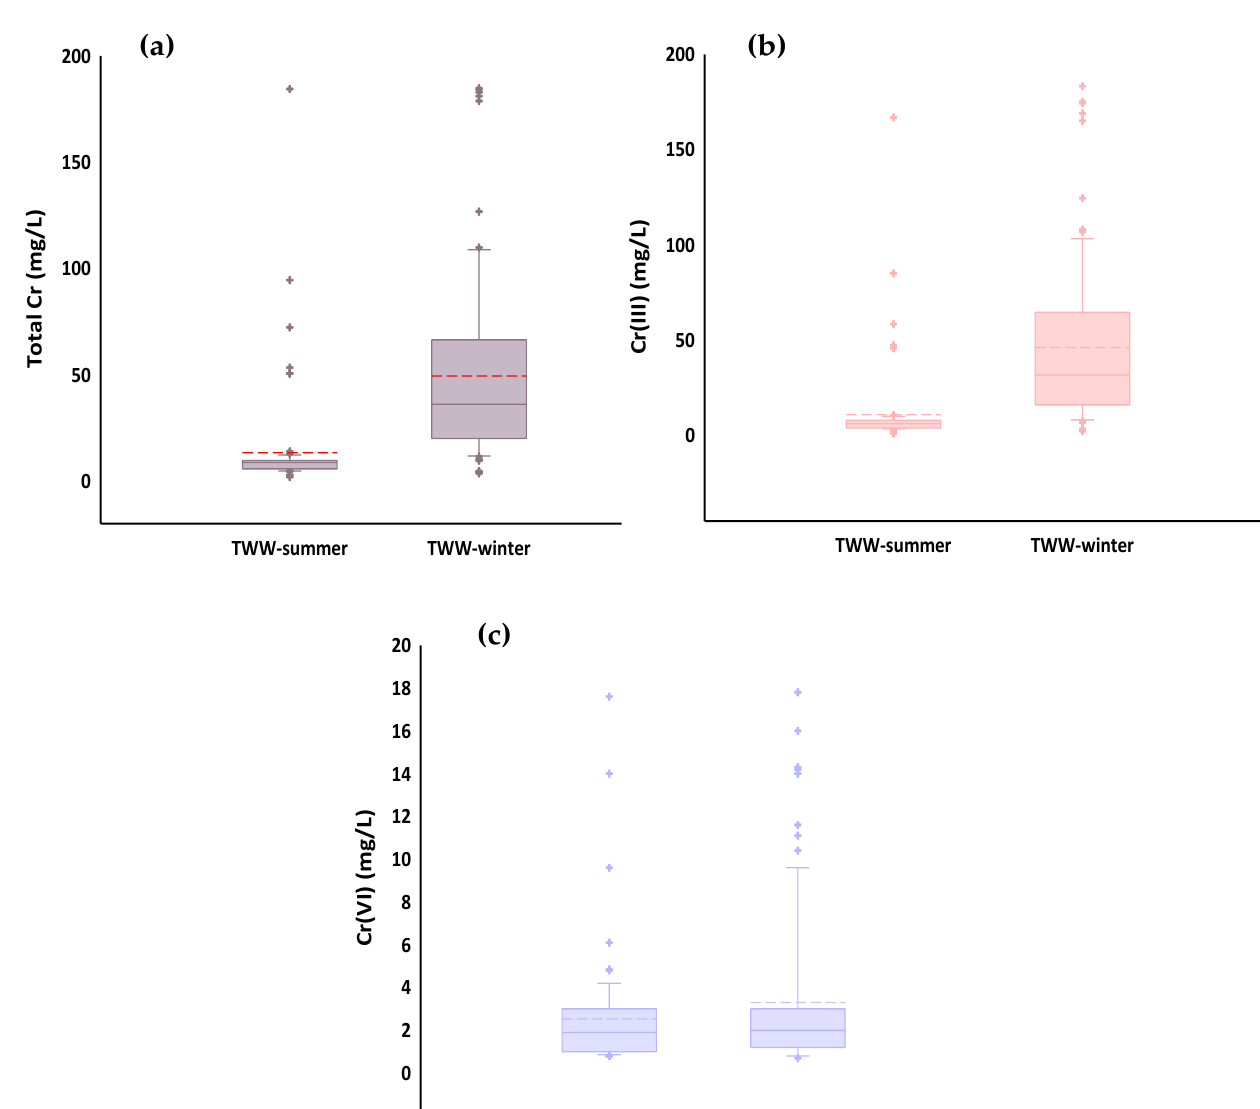
(0.05 mg L − 1 ) (WHO, 1999) (Table 2) as well as the USEPA safe limit of 2.0 mg L − 1 for Cr (USEPA, 2012) (Table 2) (USEPA, 2012).